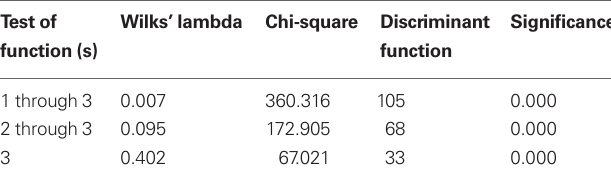
Table 3 | Wilks’ lambda test of class center separation.